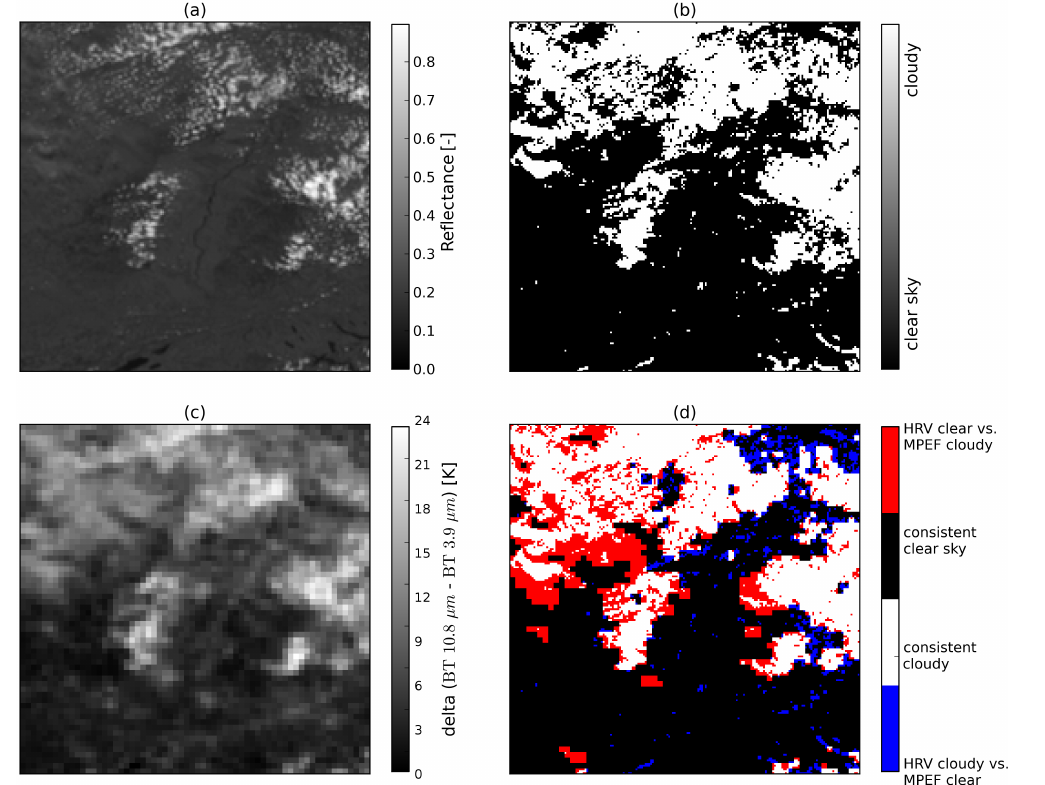
Fig. 8. (a) SEVIRI HRV reflectance over the Upper Rhine Valley on 5 July 2011, 12:00UTC and (b) HRV cloud mask (white: cloudy, black: clear-sky). (c) Corresponding brightness temperature difference BT 10.8µm − BT 3.9µm and (d) difference between MPEF and HRV cloud mask (white: cloudy, black: clear-sky, red: HRV clear-sky versus MPEF cloudy and blue: HRV cloudy versus MPEF clear-sky).